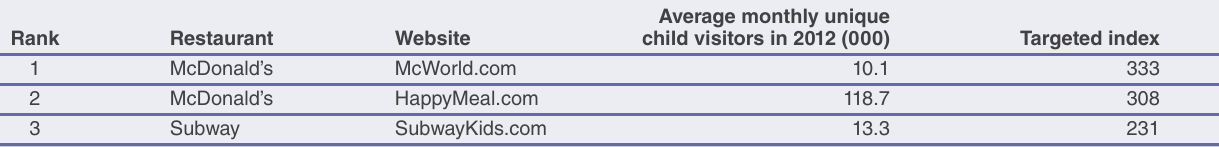
Table 26. Websites with relatively high compositions of child